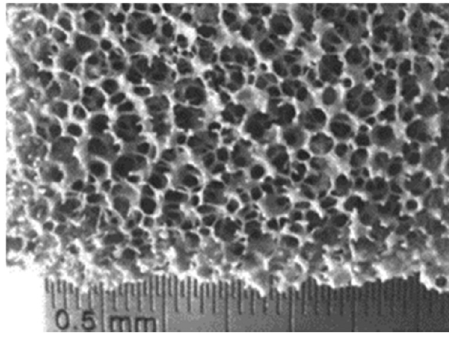
Figure 9: Porous structure of an open - cell ceramic bubble - foam [ 47,48 ]